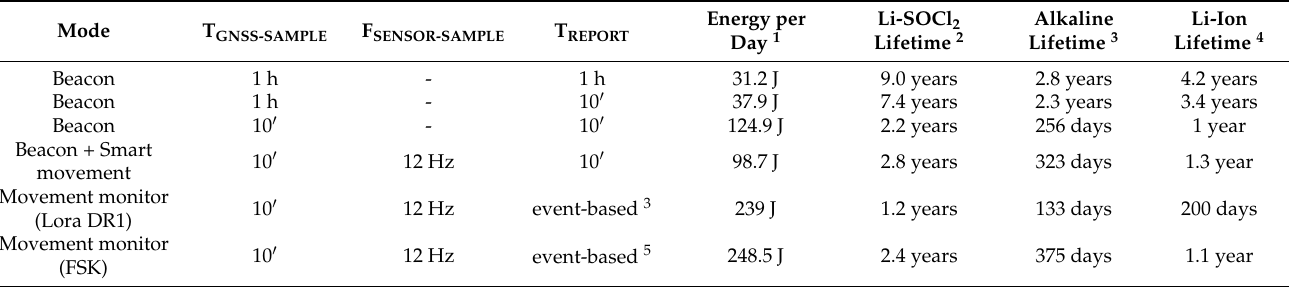
Table 2. Device mode energetical analysis.